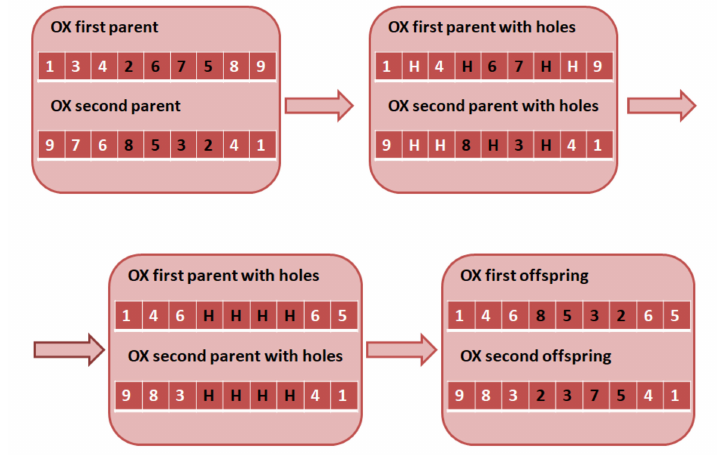
Figure 4. Order crossover (OX) operator.